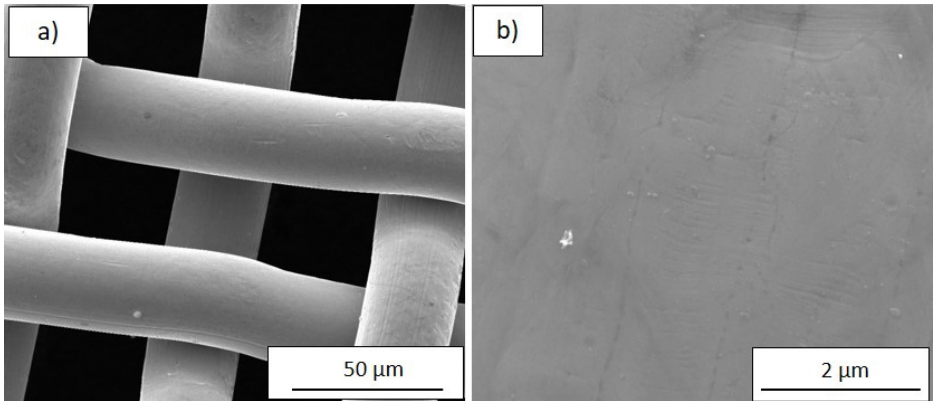
Figure 2. SEM images at ( a ) low (2000×) and ( b ) high (50,000×) magnification of the bare SSM substrate.